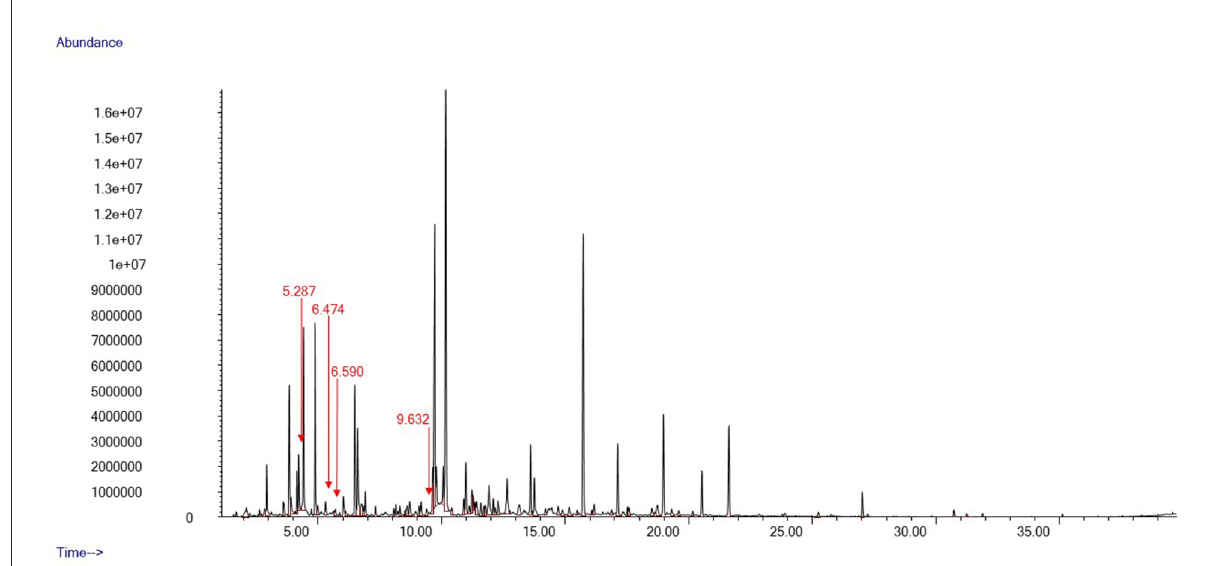
FIGURE3 Oestradiol and progesterone concentrations during the breeding period. Vertical bars denote the estimated ovulation window.